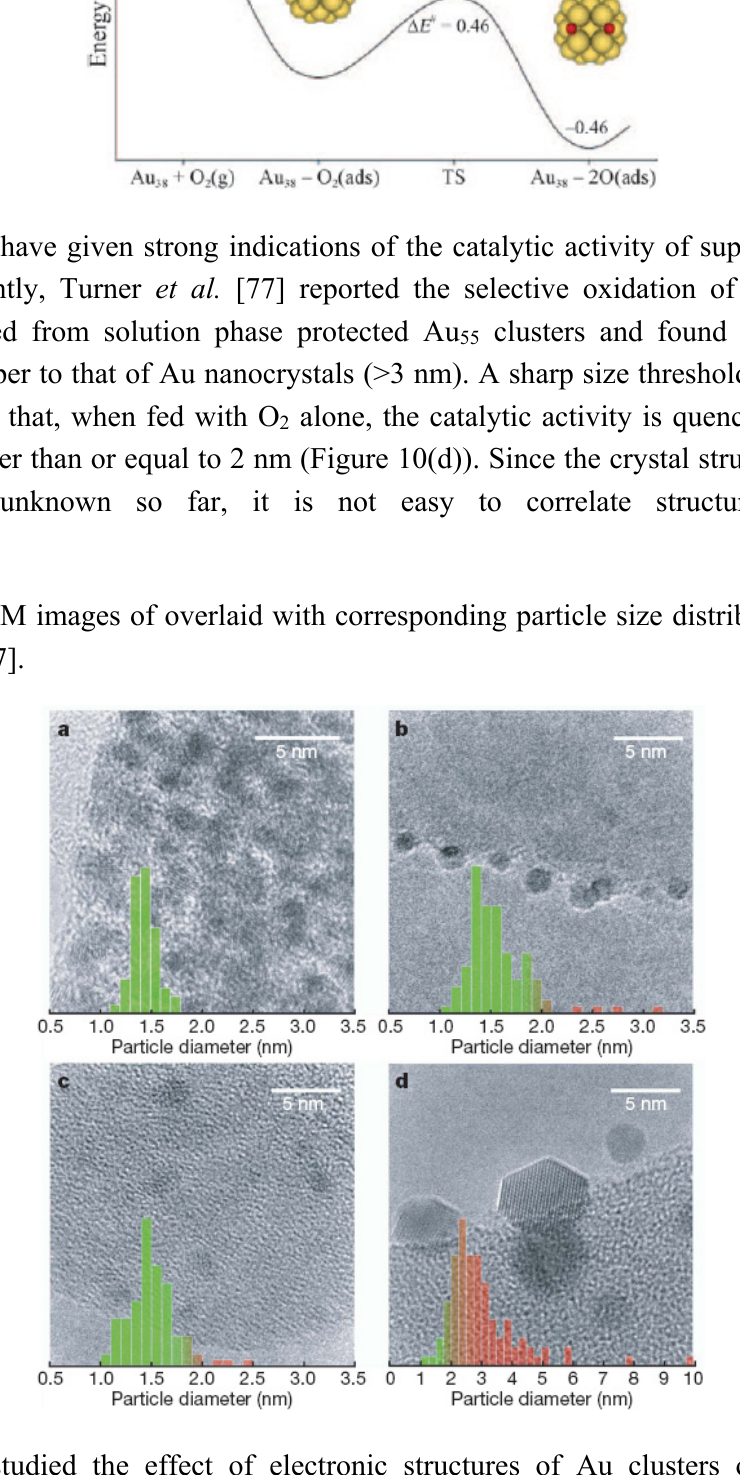
dissociation on 2